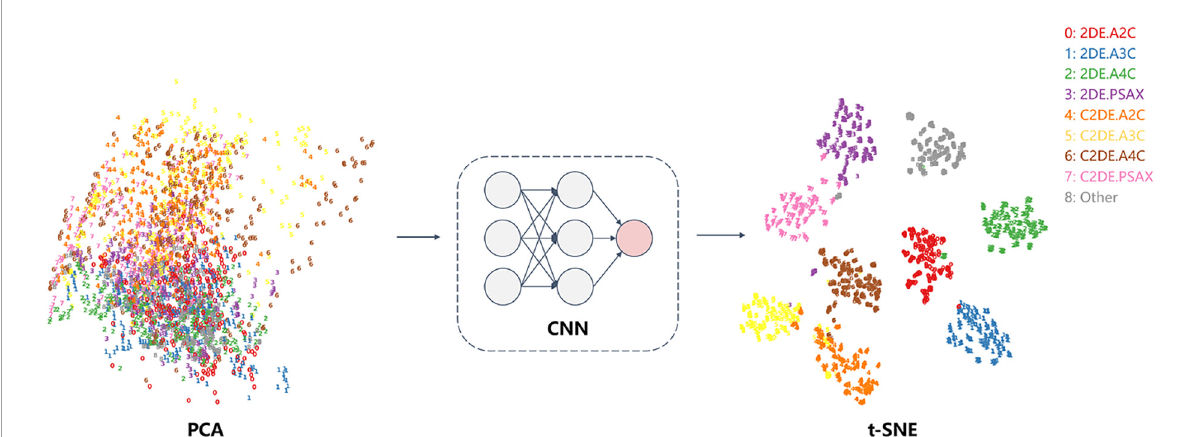
FIGURE4 t-SNE visualization of view classification. On the left, each image was plotted in 2-dimensional space from 256 × 256 pixels by principal component analysis (PCA). The results showed that the data had no clear clustering pattern. On the right, the features of the fully connected layer of the CNN model (EchoV-Net) were projected to two-dimensional space by t-SNE, displaying that images were recognized into specific view categories.